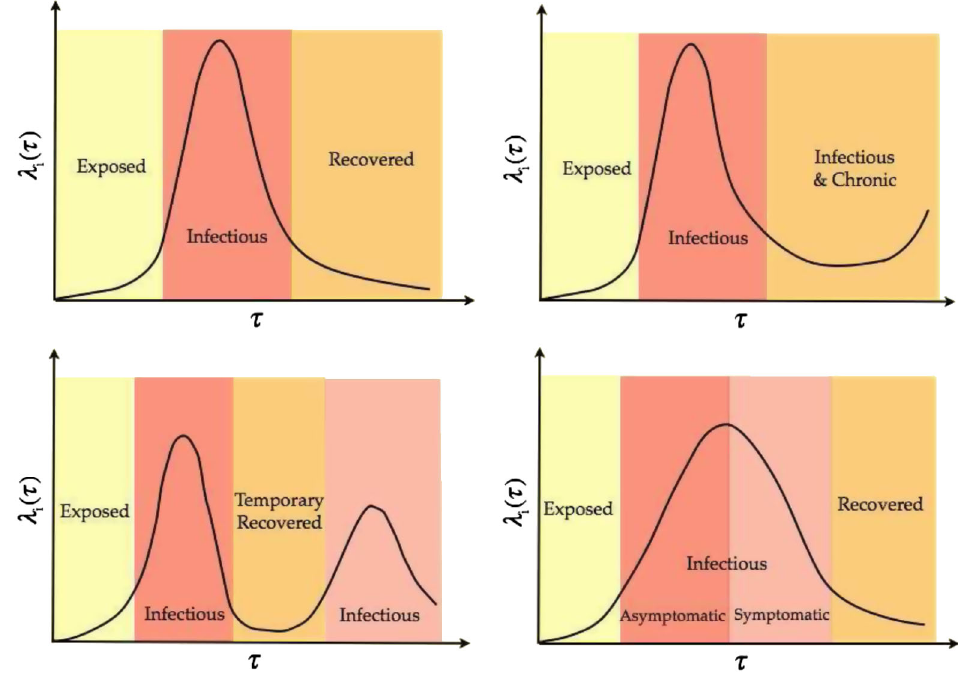
FIG. 1. Hypothetical infectivity functions (cid:1) i ð (cid:2) Þ . They show the general infectivity patterns that can occur, varying by complexity of the disease. The top left panel shows the infectivity function of a very generic disease, the top right panel shows the infectivity function of an HIV type disease, the bottom left displays the infectivity function of any recurrent disease such as chicken pox, and finally, the bottom right panel exhibits the infectivity function for an influenza type